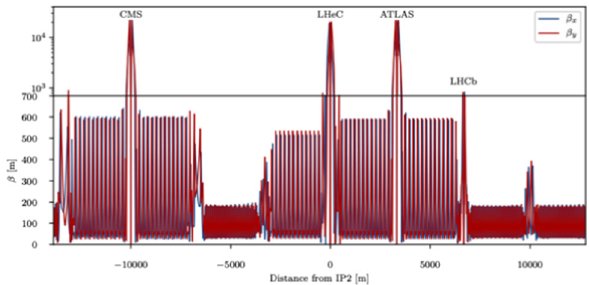
Fig. 11 Basic FMC cells of the ERL arcs: Isochronous (left) for arc 1, 2, 3 and TME lattice (right) for arc 4, 5, 6 Fig. 12 LHC proton beam optics, optimised for the LHeC design val- ues at the LHeC IP